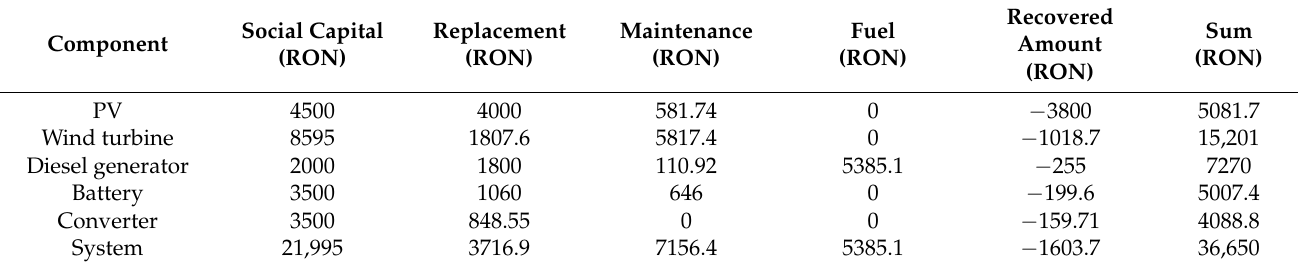
Table 5. Cost analysis of the